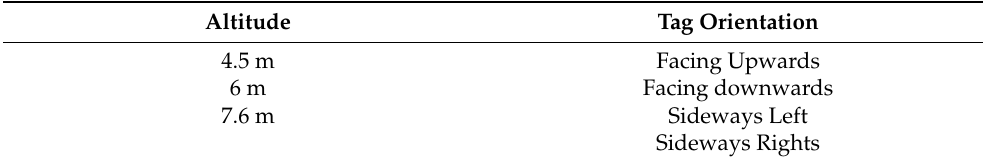
Table 5. Factors evaluated in the field experiment.